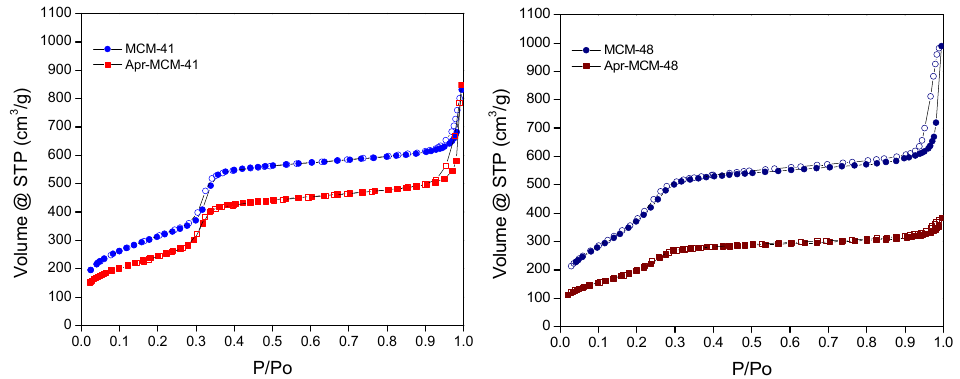
Figure 8. N 2 adsorption-desorption isotherms (77K) of MCM-41 ( left ) and MCM-48 ( right ) particles in the presence and absence of aprepitant (empty symbols: desorption).